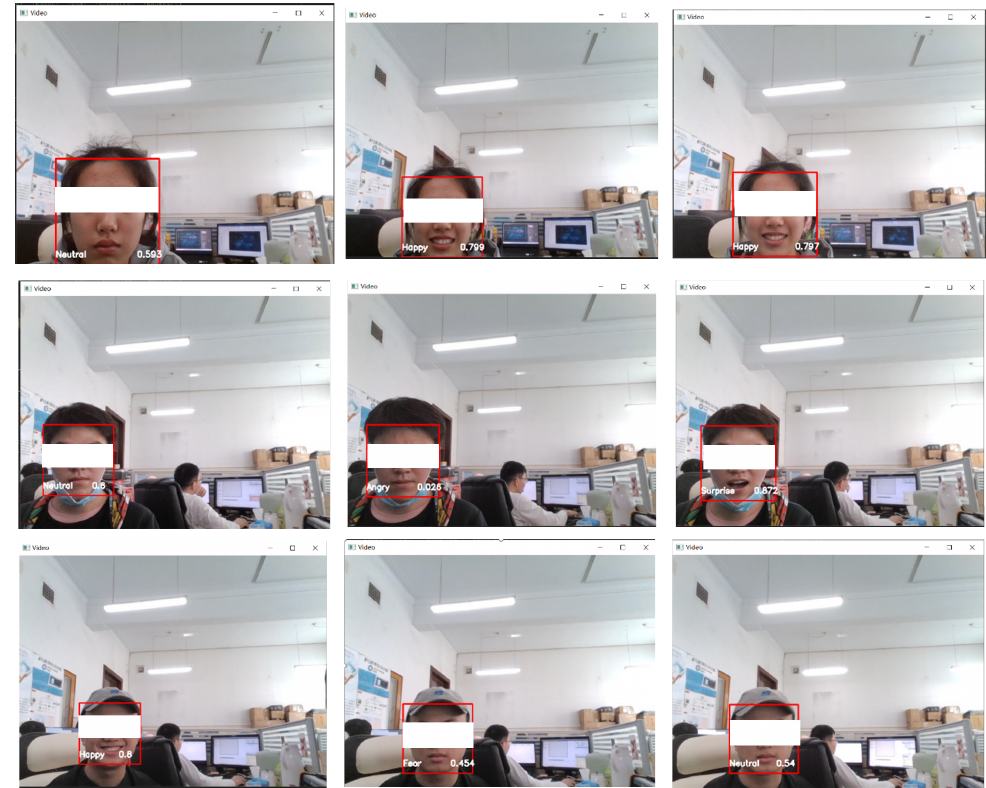
Figure 11. Expression recognition results.